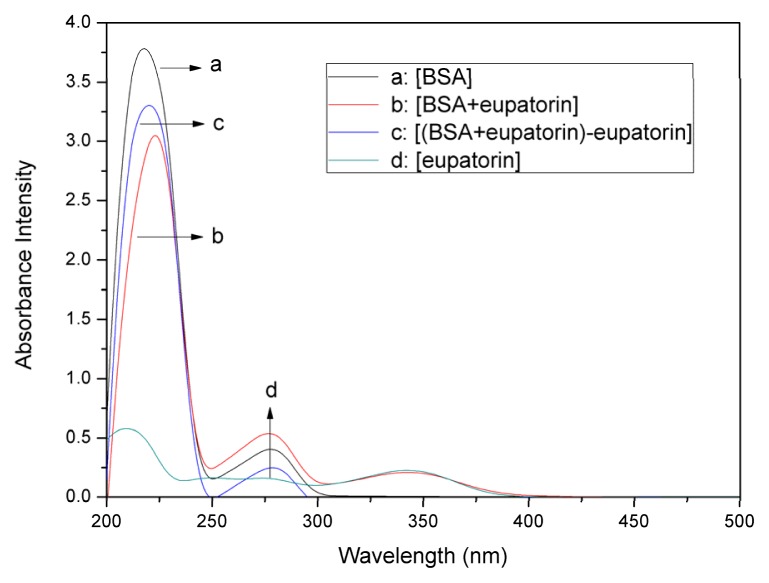
Ultraviolet-visible (UV–vis) spectra of BSA in the presence of eupatorin (T = 298 K, pH 7.4): (a) Absorption spectrum of bovine serum albumin (BSA) only; (b) Absorbance spectrum of eupatorin—BSA when the molar ratio is 1:1; (c) Difference absorption spectrum between eupatorin—BSA and eupatorin; (d) Absorption spectrum of eupatorin only. CBSA = Ceupatorin = 1.0 × 10−5 M.